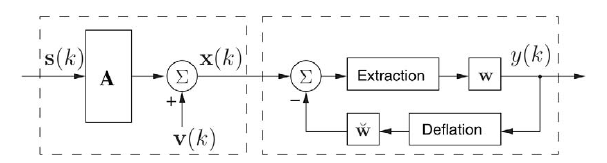
FiGurE 2 | The noisy mixture model, and BSE